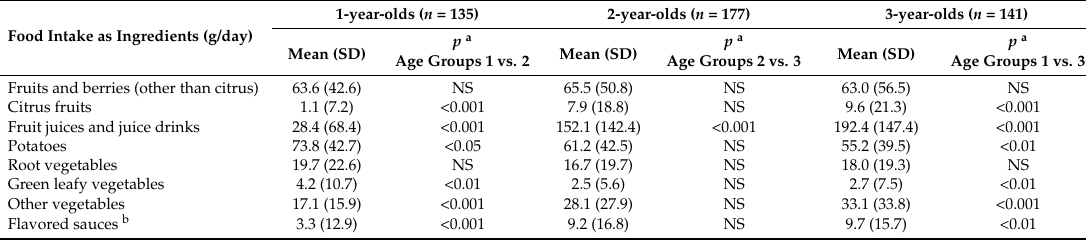
Table 2. Estimated daily dietary intake of α - and β -carotene food sources as ingredients in 1-, 2-, and 3-year-old Finnish